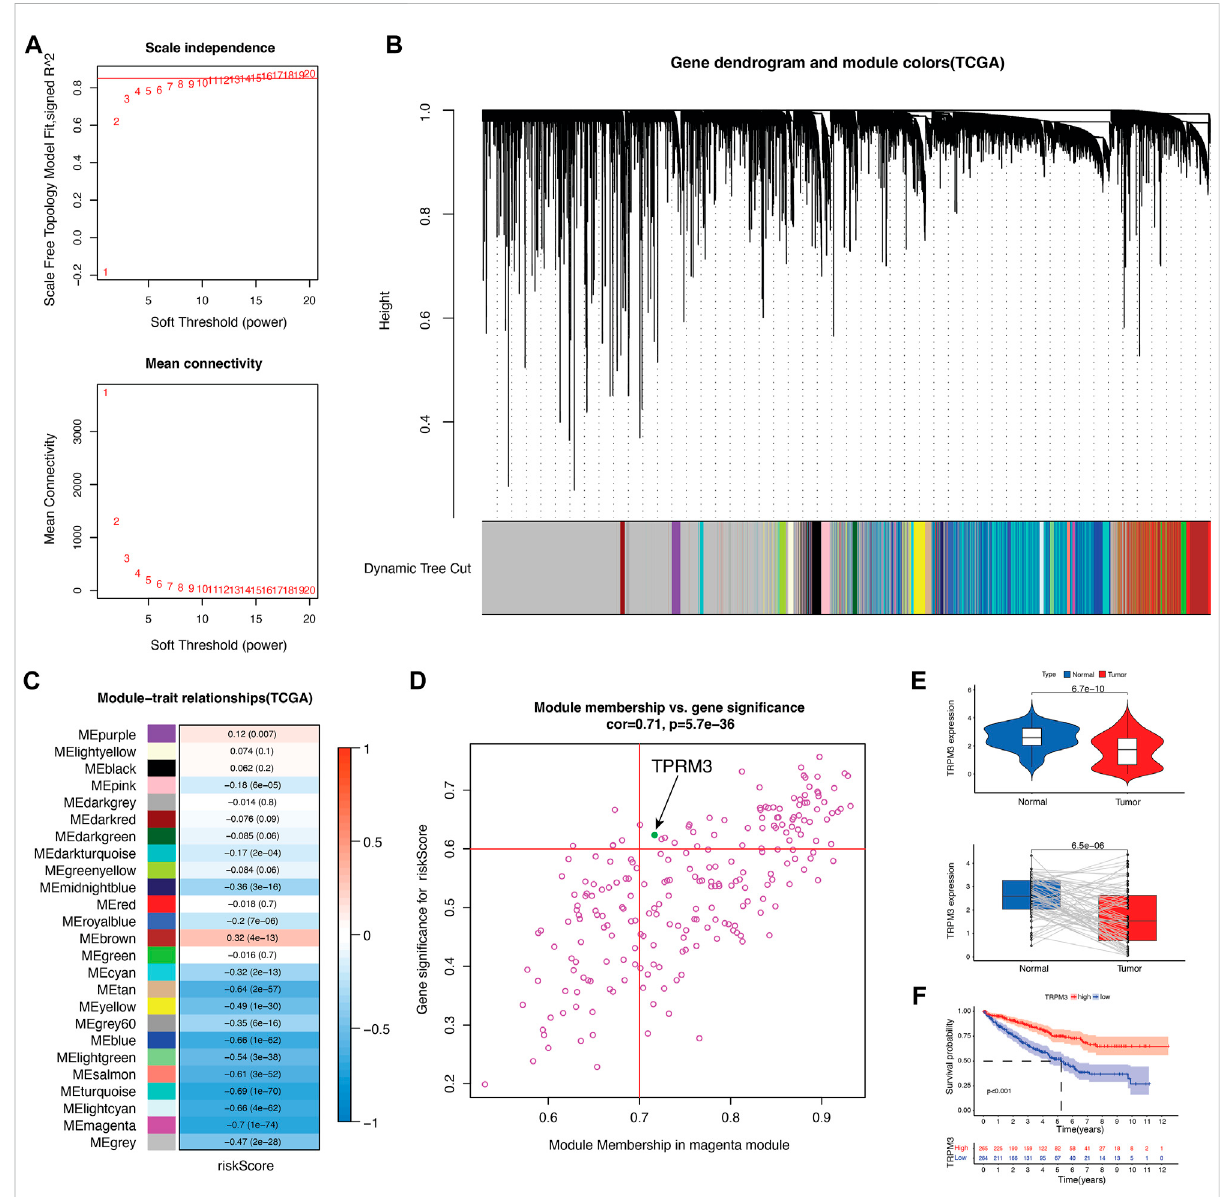
FIGURE 8 Identify key CRG in KIRC. (A) scale-free co-expression network. (B) 25 gene modules were obtained in a dendrogram. (C) The correlation coef fi cientandcorresponding p -valuebetweeneachgenemoduleandriskscore. (D) Scatterplotofmoduleeigengenesinthemagentamodule.